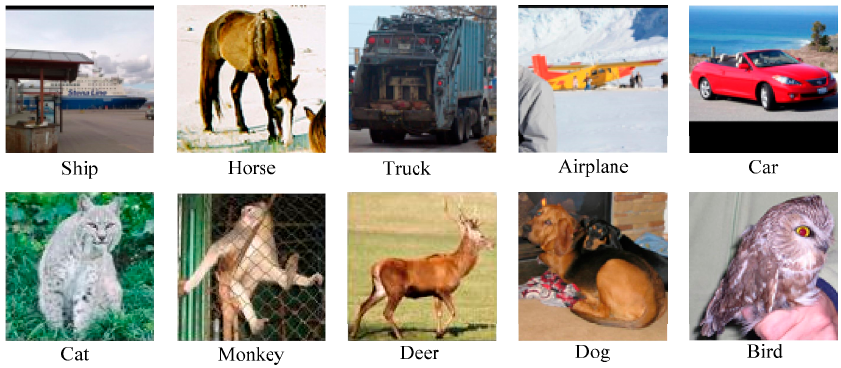
Figure 4. Some example images of STL-10 dataset.